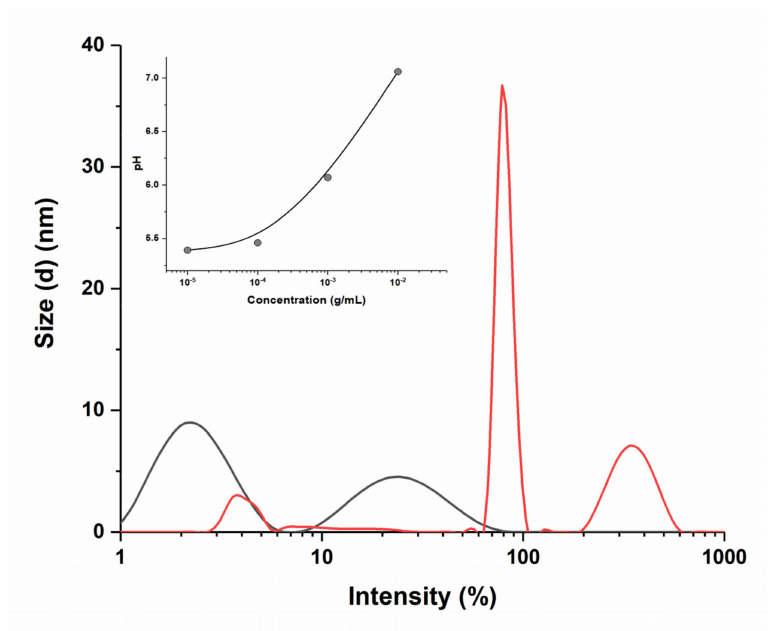
Figure 2. Particle size distribution in BSA colloid system depending on protein concentration (g/mL): red line—1 × 10 − 5 (0.15 µ M), black line—1 × 10 − 2 (150 µ M); pH dependance on concentration (g/mL) is shown in the